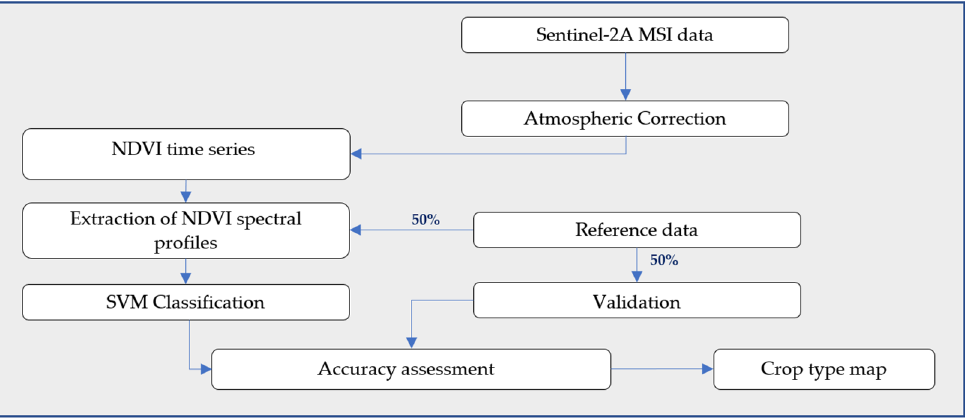
Figure 5. The flowchart of the methodology used for crop type mapping.